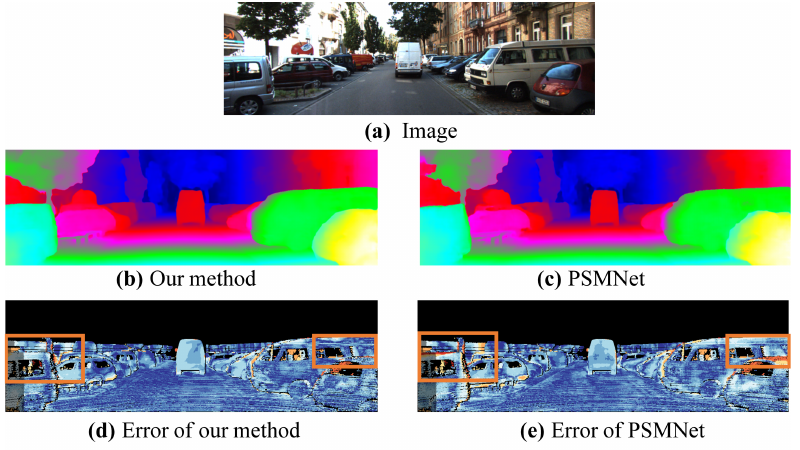
Figure 10. Illustration of the effect on boundary region in an example from KITTI 2015. ( a ) is the original image, ( b ) is the result of our method, ( c ) is the result of the baseline model, ( d ) is the disparity error map of our method and ( e ) is the error map of the baseline